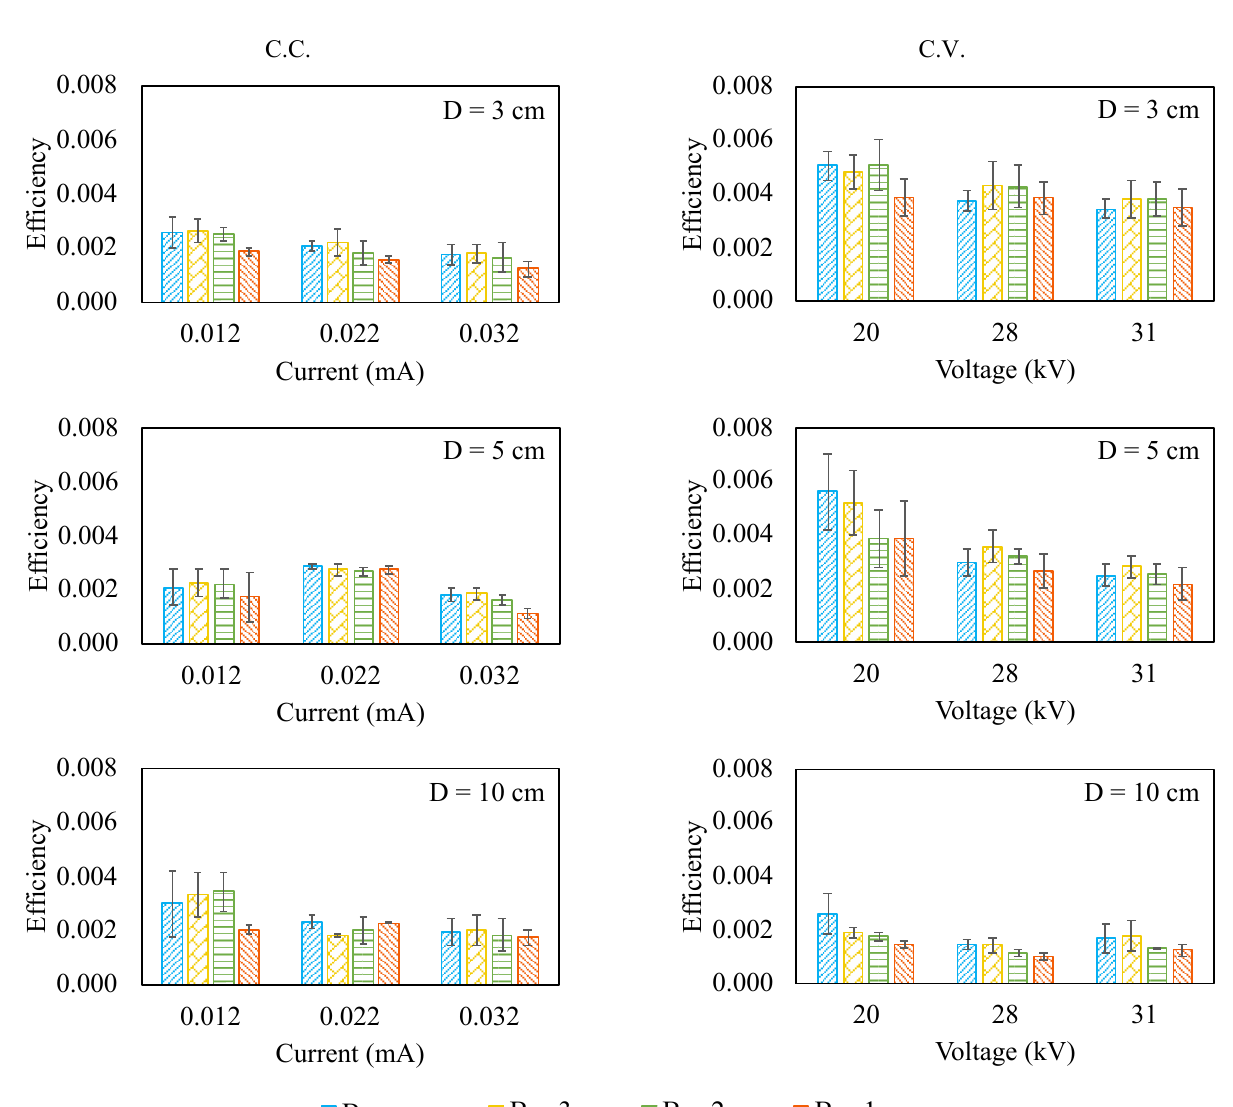
Figure 5. The energy efficiency for the ionic wind pump under test.